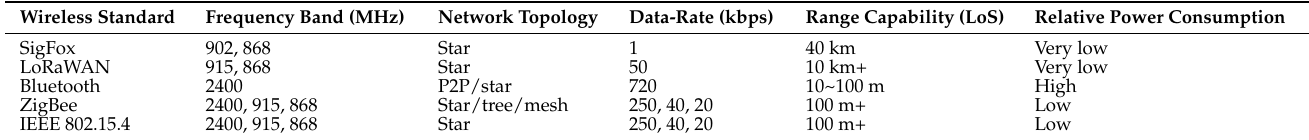
Table 8. WSN standards